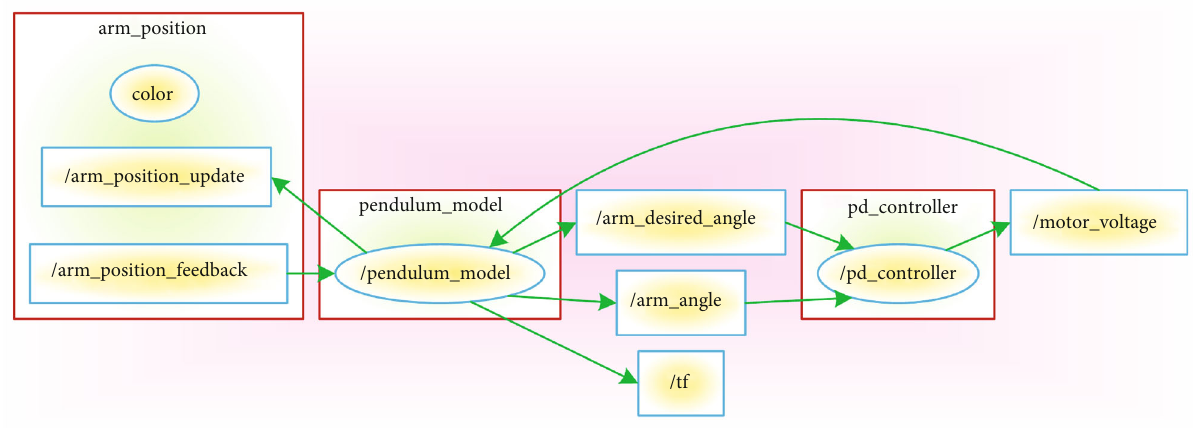
Figure 3: Nodes and topics associated with the simulation environment in ROS.